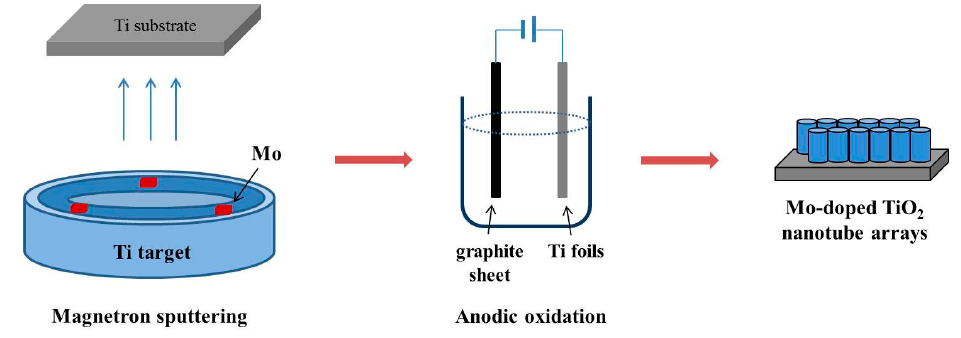
Figure 1. Schematic diagram of Mo-doped TiO 2 nanotube arrays preparation.